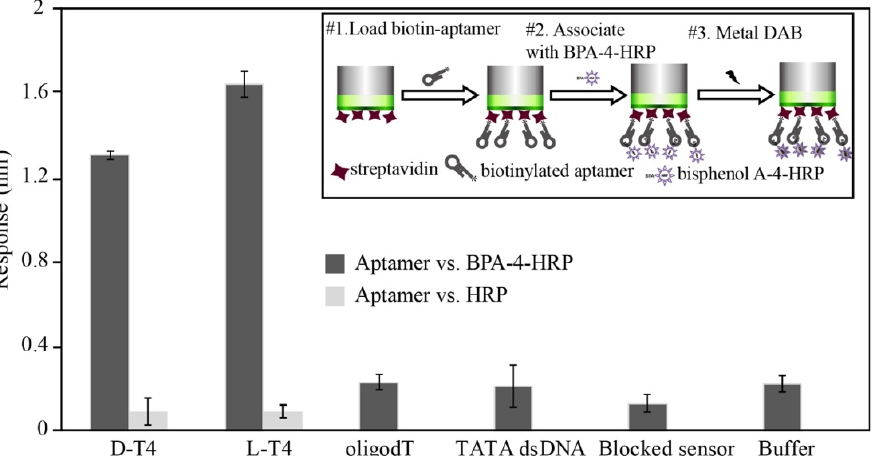
Figure 4. Schematic diagram (upper right-hand inset) and results of the affinity ranking by the SA sensor in the BLI analysis. BPA-HRP conjugate was captured by BPA aptamer on the sensor surface, and subsequent HRP activity was detected by metal DAB.